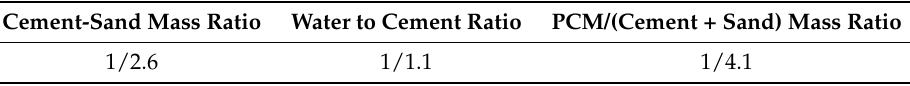
Table 1. Mix proportion of cement mortar integrating PCM Micronal ® .